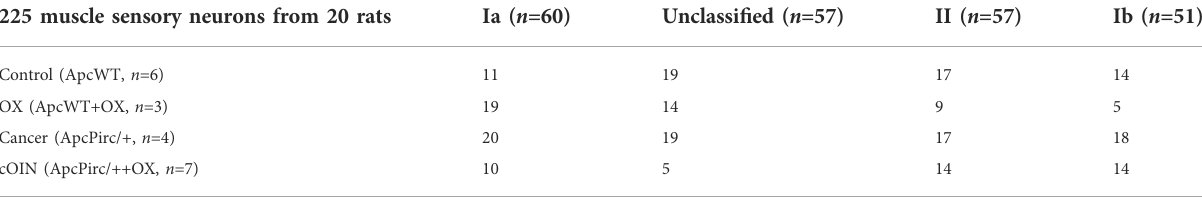
TABLE 1 Distribution of data. Breakdown of neuronal classes in top row and experimental group left most column. 225 muscle sensory neurons from 20 rats